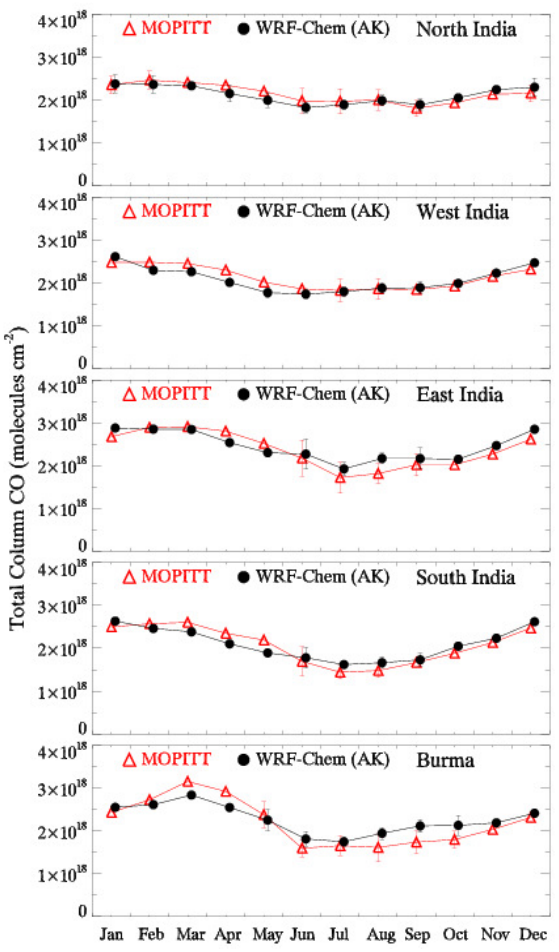
Figure 11: Seasonal variations in WRF-Chem simulated and MOPITT retrieved CO total 1326 Fig. 11. Seasonal variations in WRF-Chem simulated and MOPITT- retrieved CO total column over the five regions defined in Fig. column over the five regions defined in Figure 1. 1327